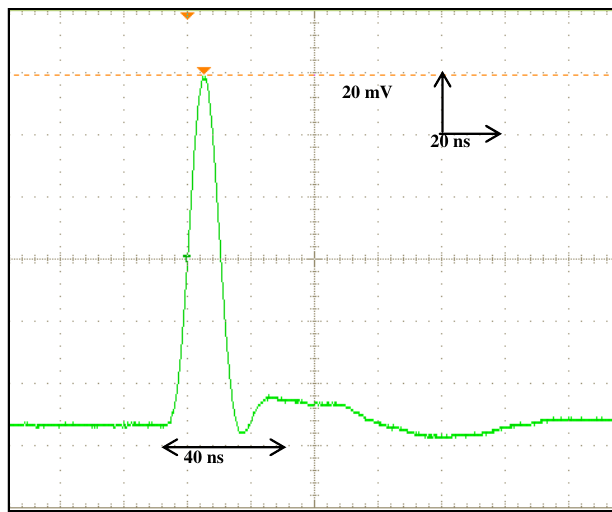
FIG. 12. (Color) Output signal from the signal